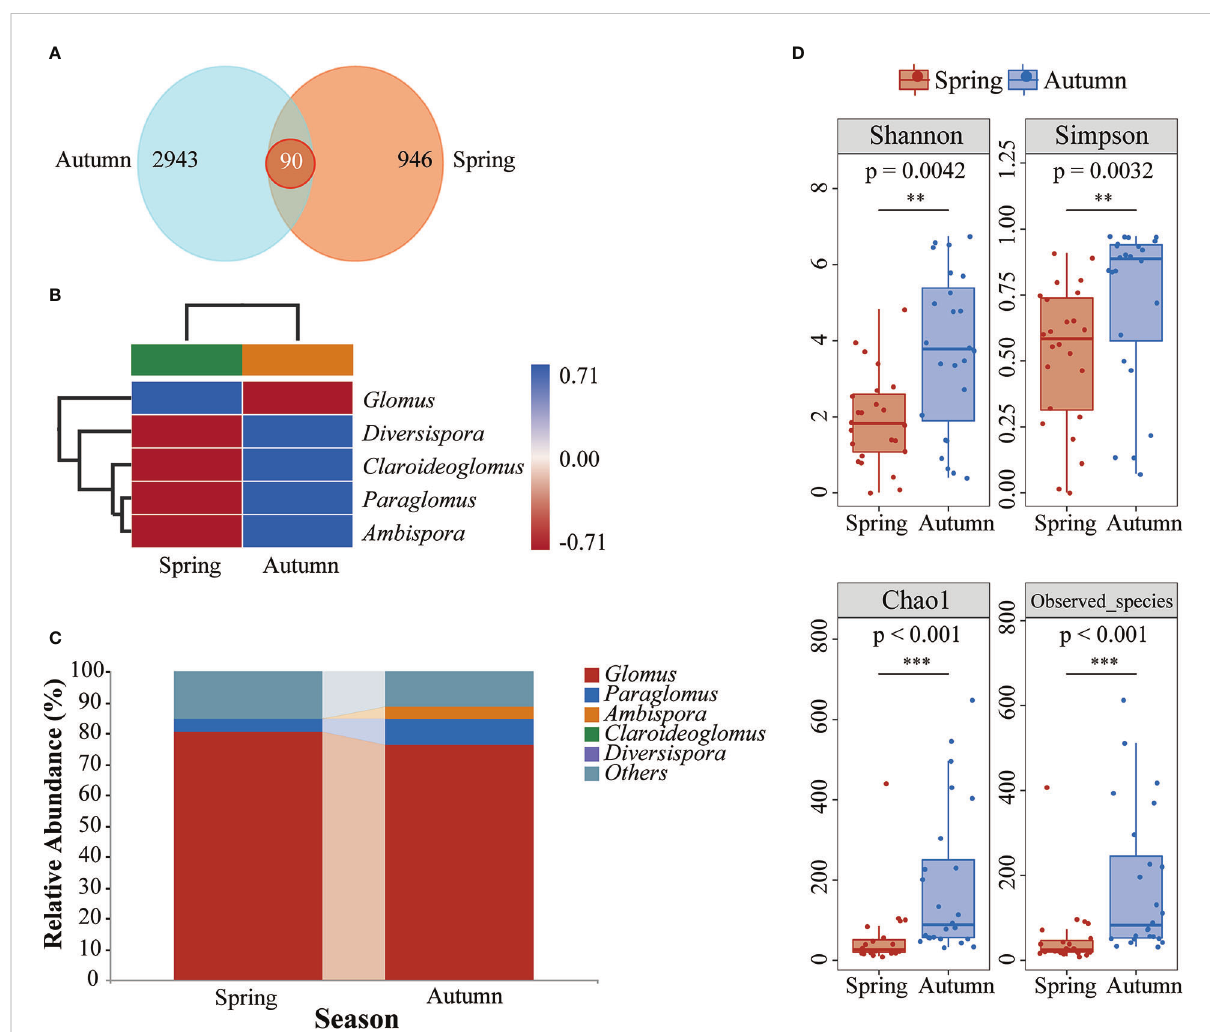
FIGURE 3 Effects of seasonal changes on the AMF community composition of poplar roots. (A) Venn diagram of AMF communities based on the ASV level. (B) Relative abundances of species at the genus level. (C) Heatmap of species composition at the genus level. (D) Alpha diversity indices of the AMF communities of poplar roots. **0.001 < p < 0.01; *** p <